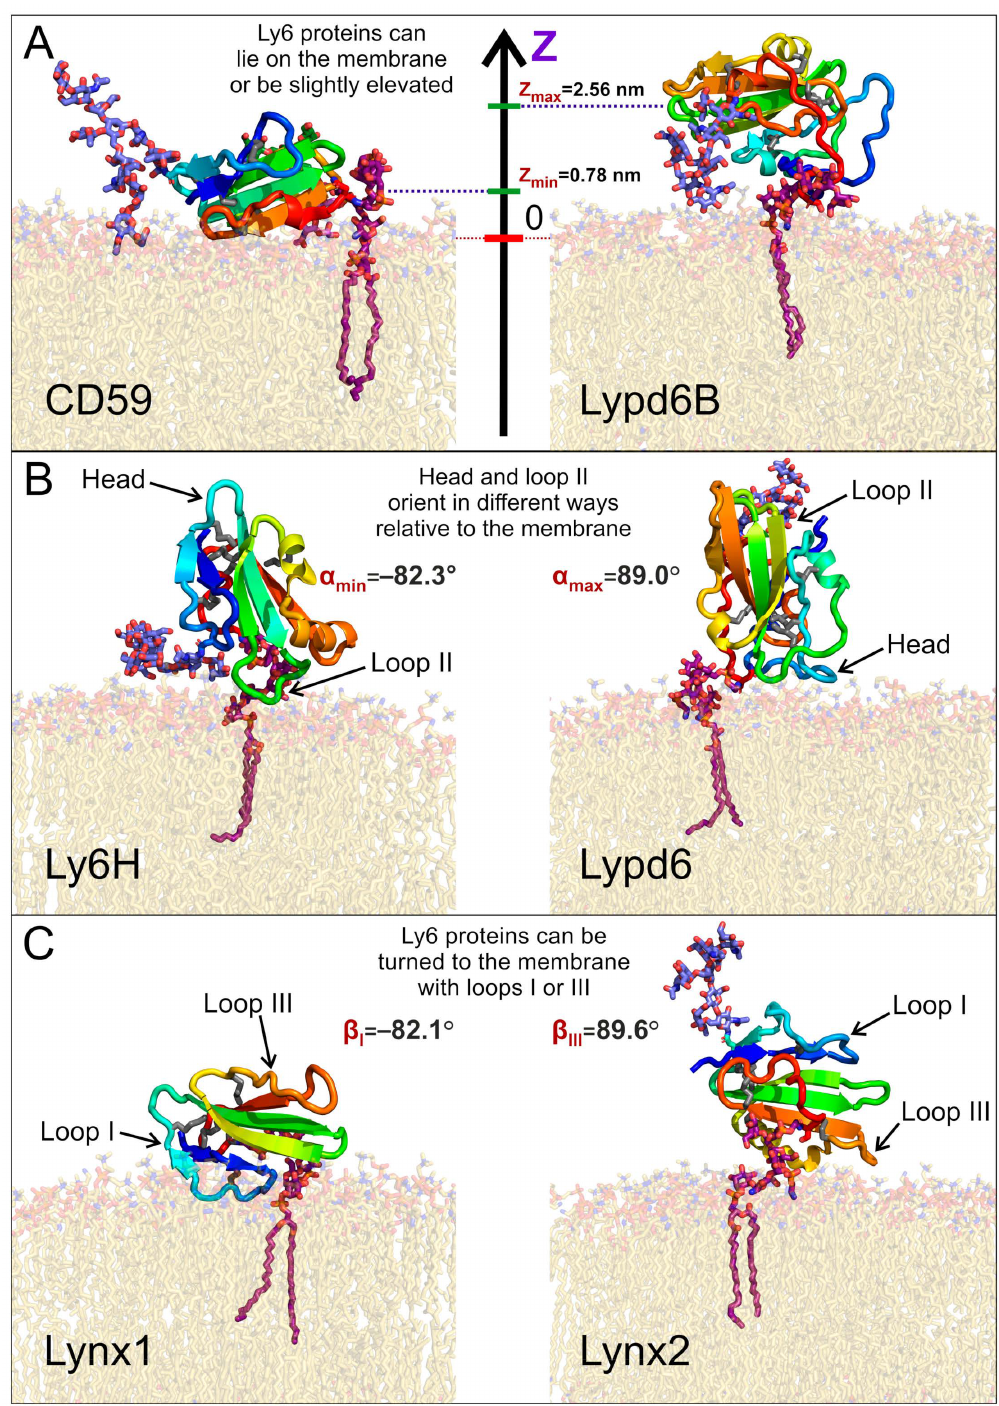
Figure 3. Diversity of the GPI-anchored Ly6 protein positions (A) and orientations (B,C) relative to the membrane. Extremal modes with highest and lowest values of the center of mass (COM) position (Z), tilt angle α , and rotation angle β are shown on panels A , B , and C , respectively. Minimal and maximal obtained values are provided. Positions of presented modes in α / β -coordinates are marked in Figure